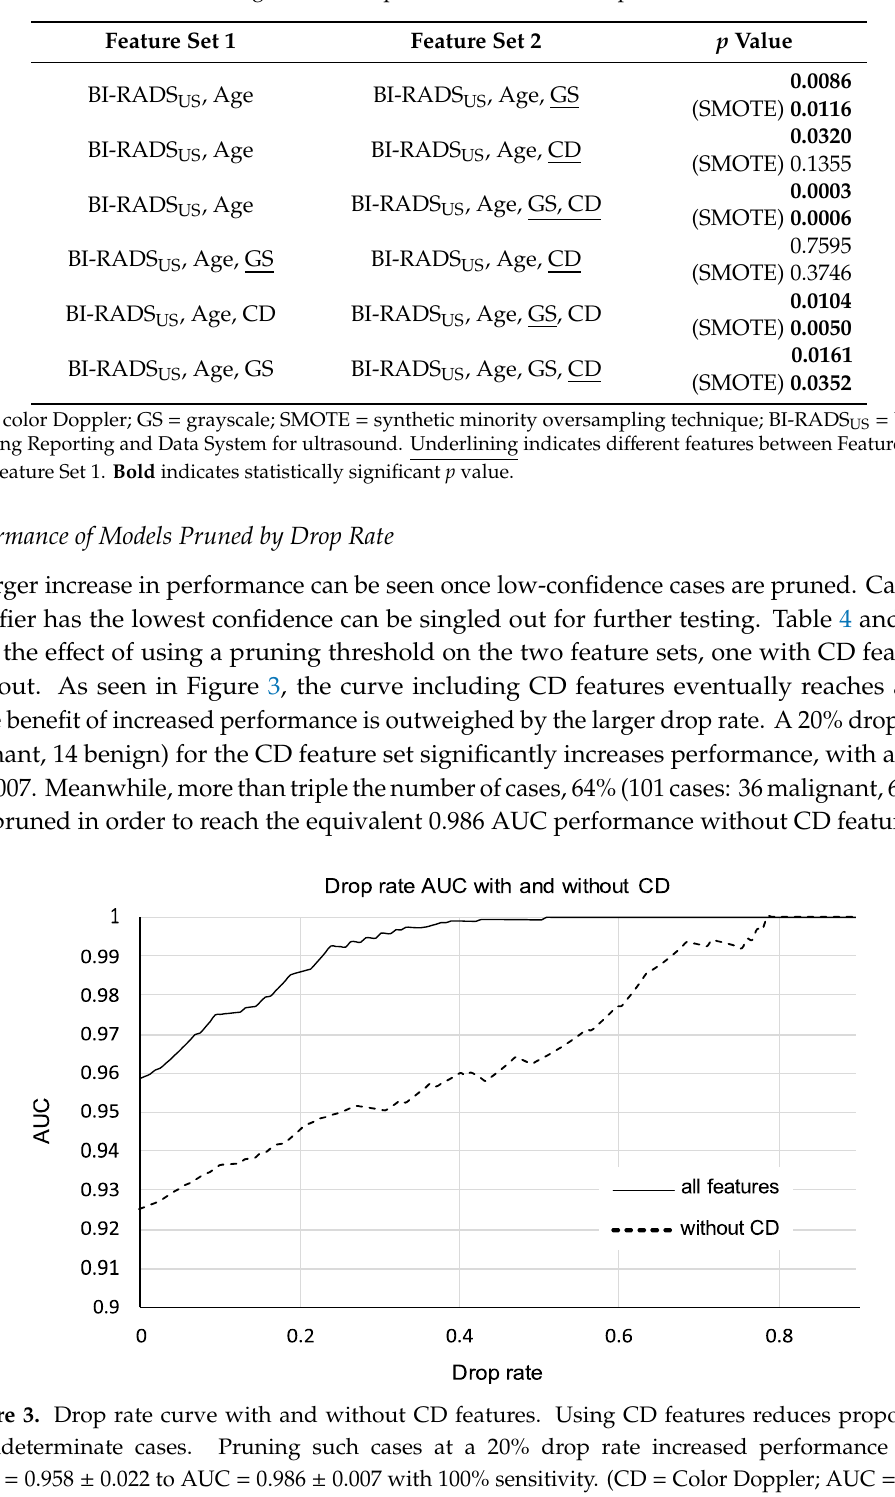
Table 3. Significance of paired feature set AUC performance.